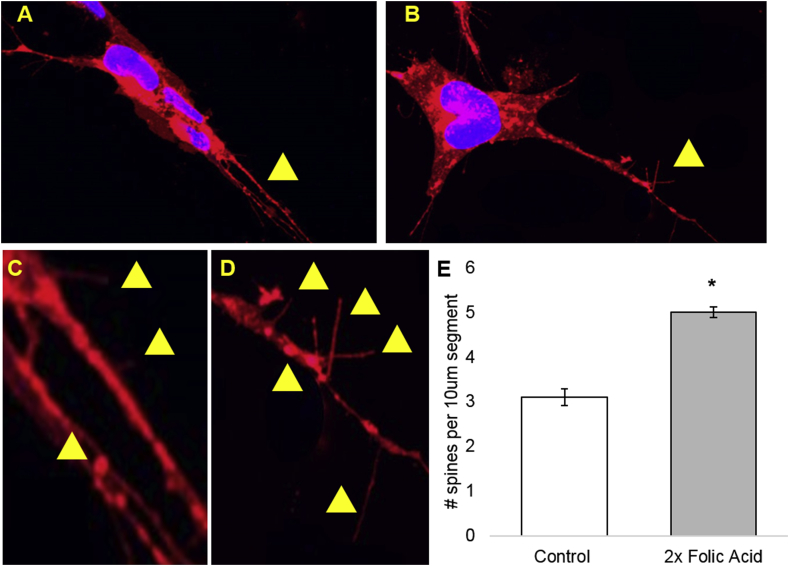
A and B. Representative images for control (A) and 2x FA treated (B) SHSY5Y cells. Images were used to perform dendritic spine counts. Yellow arrows indicate regions that are zoomed-in in C and D. C and D. Zoomed-in figures of representative images for control (C) and 2x FA treated (D) SHSY5Y cells. Yellow arrows indicate locations or regions of spines. E. Overall dendritic spine counts as number of dendritic spines per 10 μm segment; p = 0.00011. Error bars are ± 1 standard error. An asterisk (*) indicates p < 0.05 using a paired two-tailed t-test.